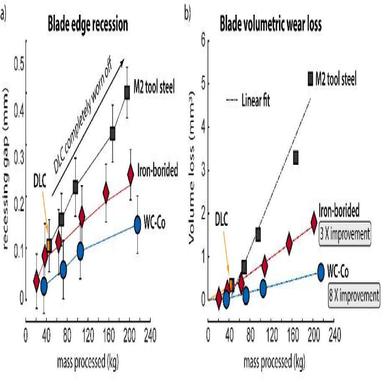
Wear performance of the three different sets of blades in the knife mill tests. a) Average recessing gaps of the blade tips over the amount of feedstock processed. b) Average volume losses of the blade tips converted from the recessing gaps over the amount of feedstock processed.